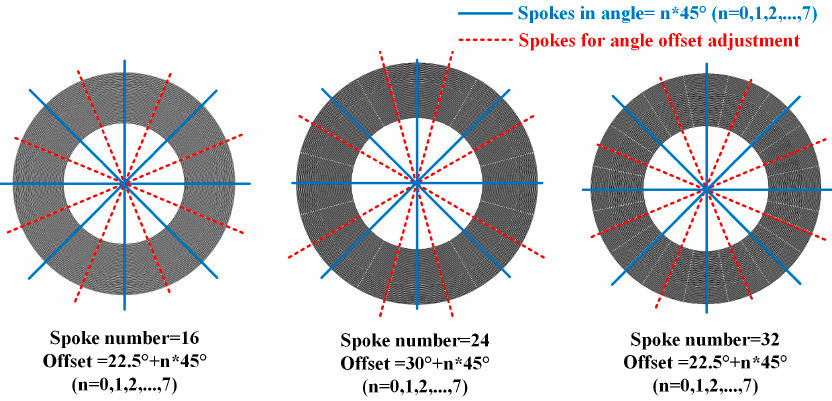
Figure 3. The offset angle locations in DRGs with different spoke number.